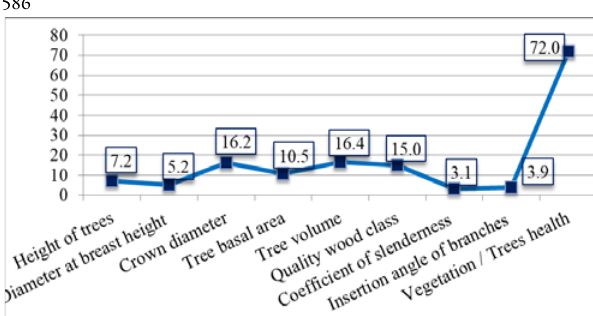
Fig. 2. Coefficient of variability (CV%) for the analysed traits of spruce trees ( Picea abies ), calculated in ensemble for nine plots with different exposition and altitude